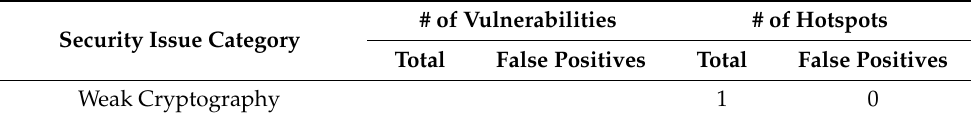
Table 17. Number of security issues of different categories in the MicroWebSrv webserver.